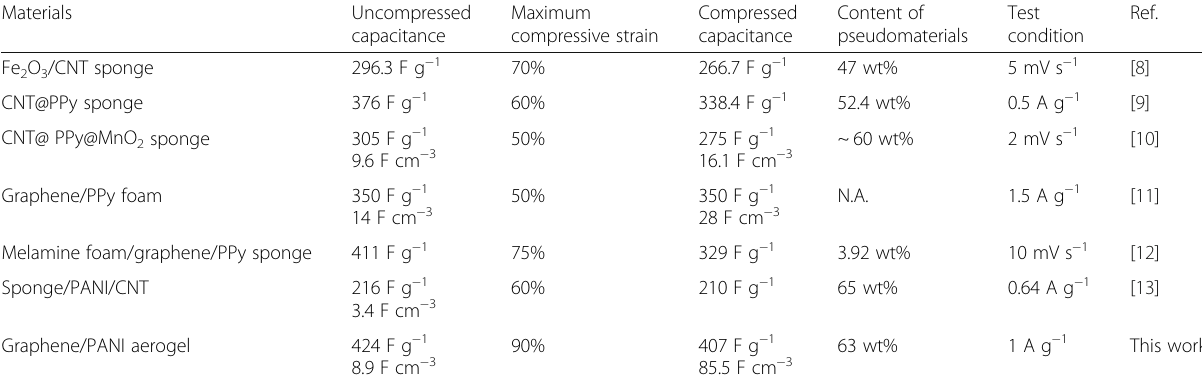
Table 1 Comparison of the compressible composite electrodes. The capacitances are obtained with symmetric full